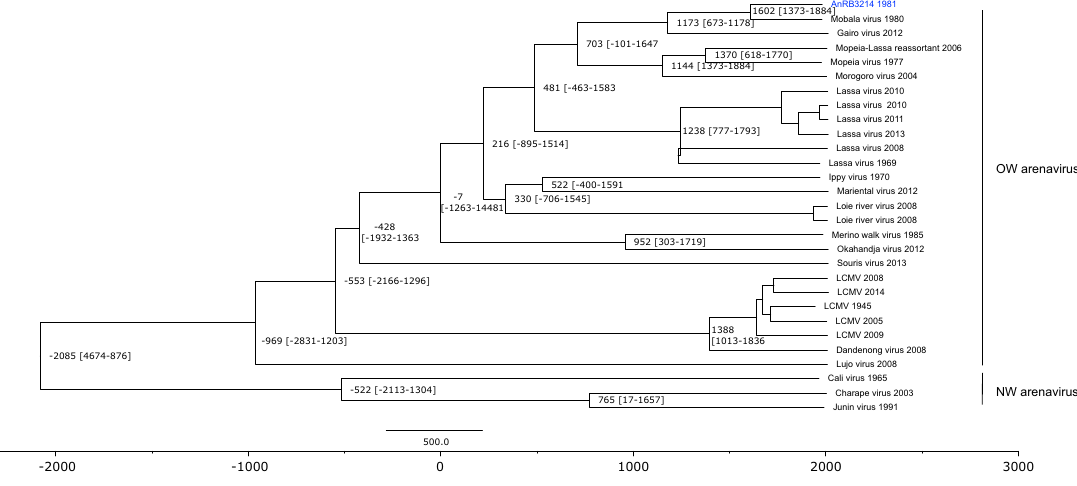
Figure 4. Molecular clock analysis of strain AnRB3214 using BEAST v1.10.4. The clock shows two monophyletic arenavirus groups which seems to have diverged some 5000 years ago. AnRB3214 strain (in blue) diverged from an ancestor in common with Mobala virus around year 1602 [year 1373- year 1884]. BEAST v1.10.4 (https:// www. beast2. org/) was used for the Bayesian Monte Carlo Markov chain (MCMC) inference and the chronogram was generated with TreeAnnotator v1.10.4 (https:// beast. commu nity/ treea nnota